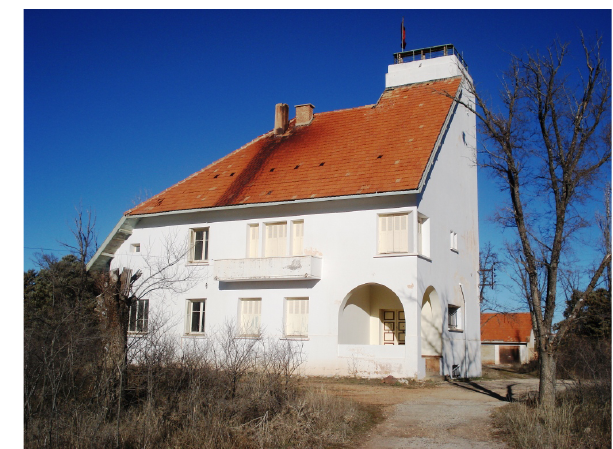
Figure 8. Main building of the Ifrane Observatory. Courtesy of T. E. Cherkaoui.